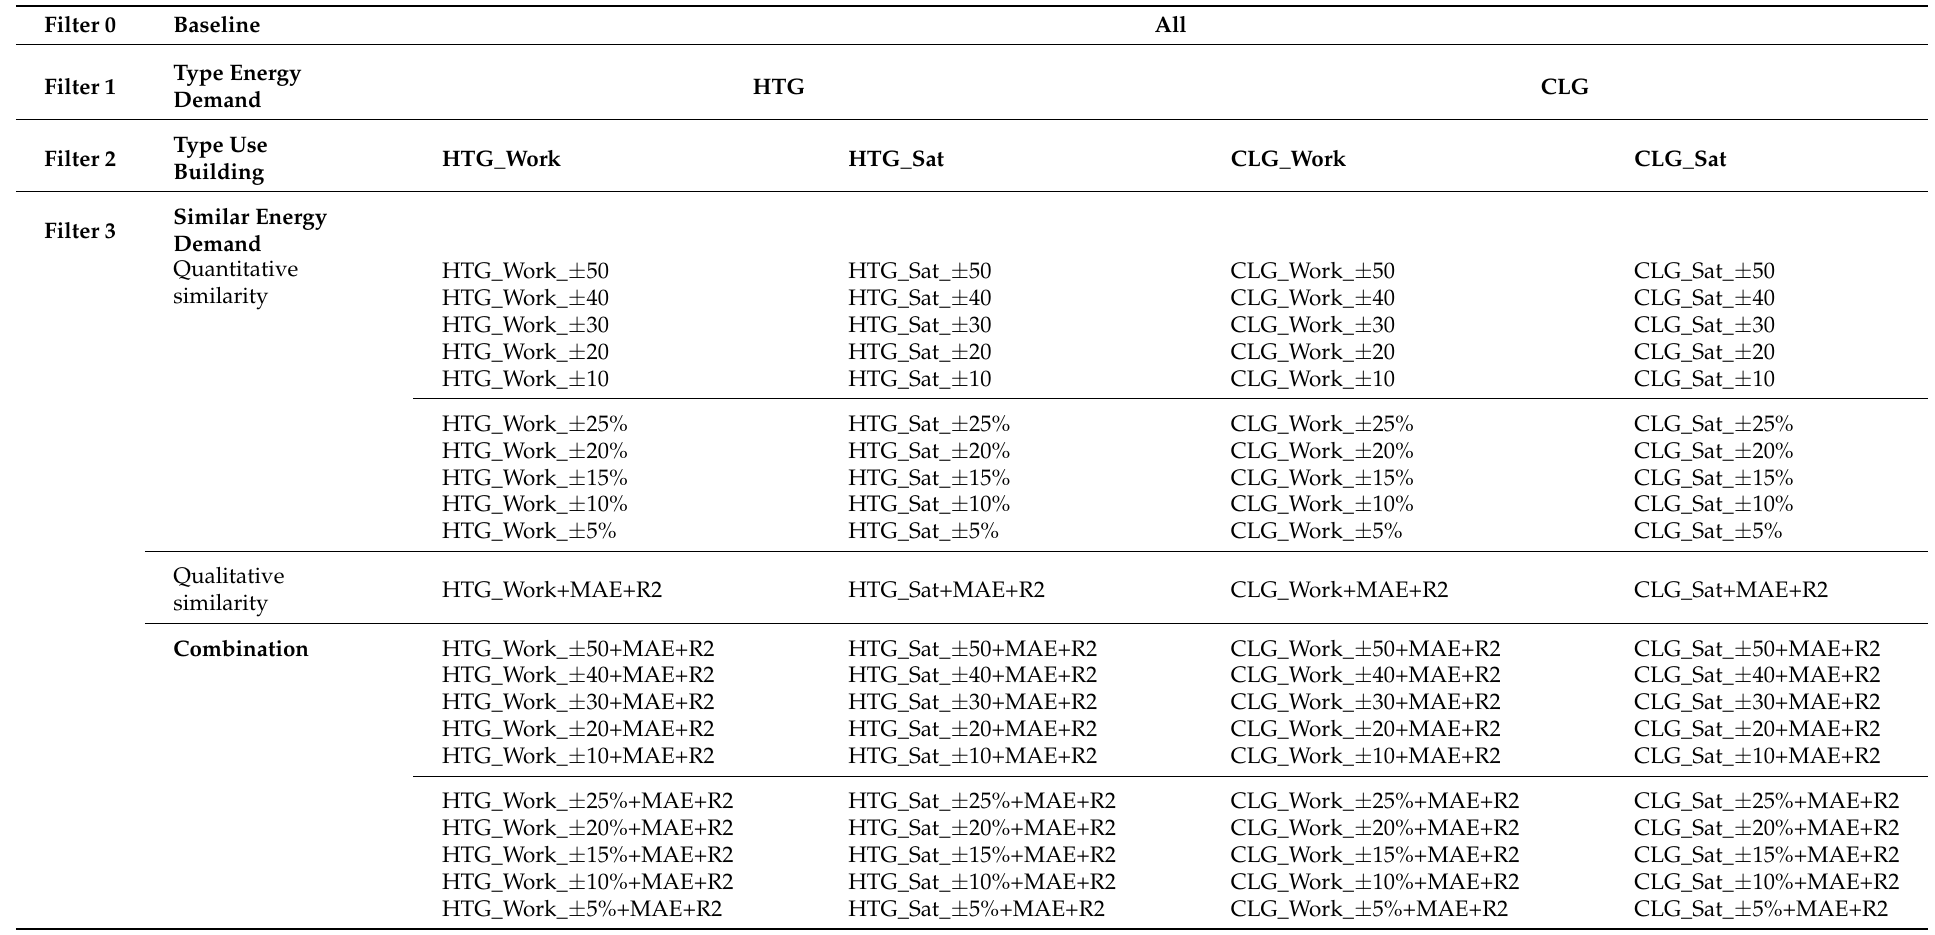
Table 1. Characterization filters of the training days for the calculation of the